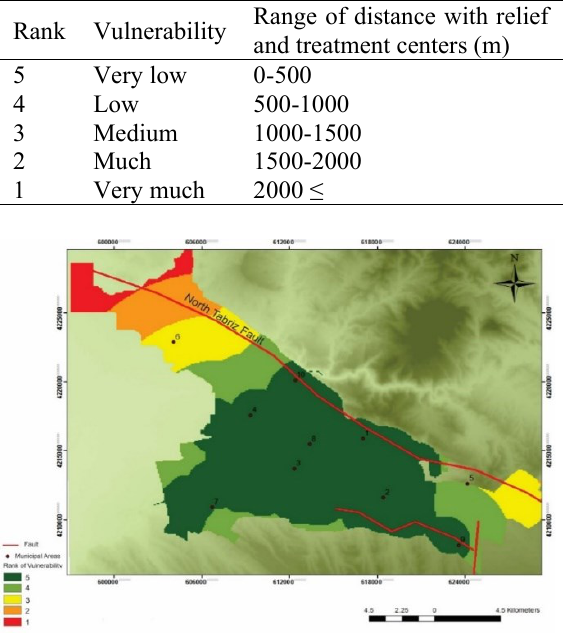
Table 6. Vulnerability and its ranking based on range